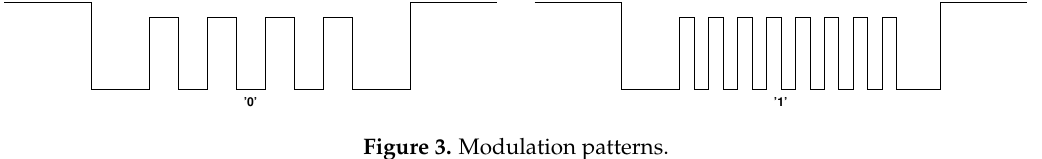
Figure 3. Modulation patterns.